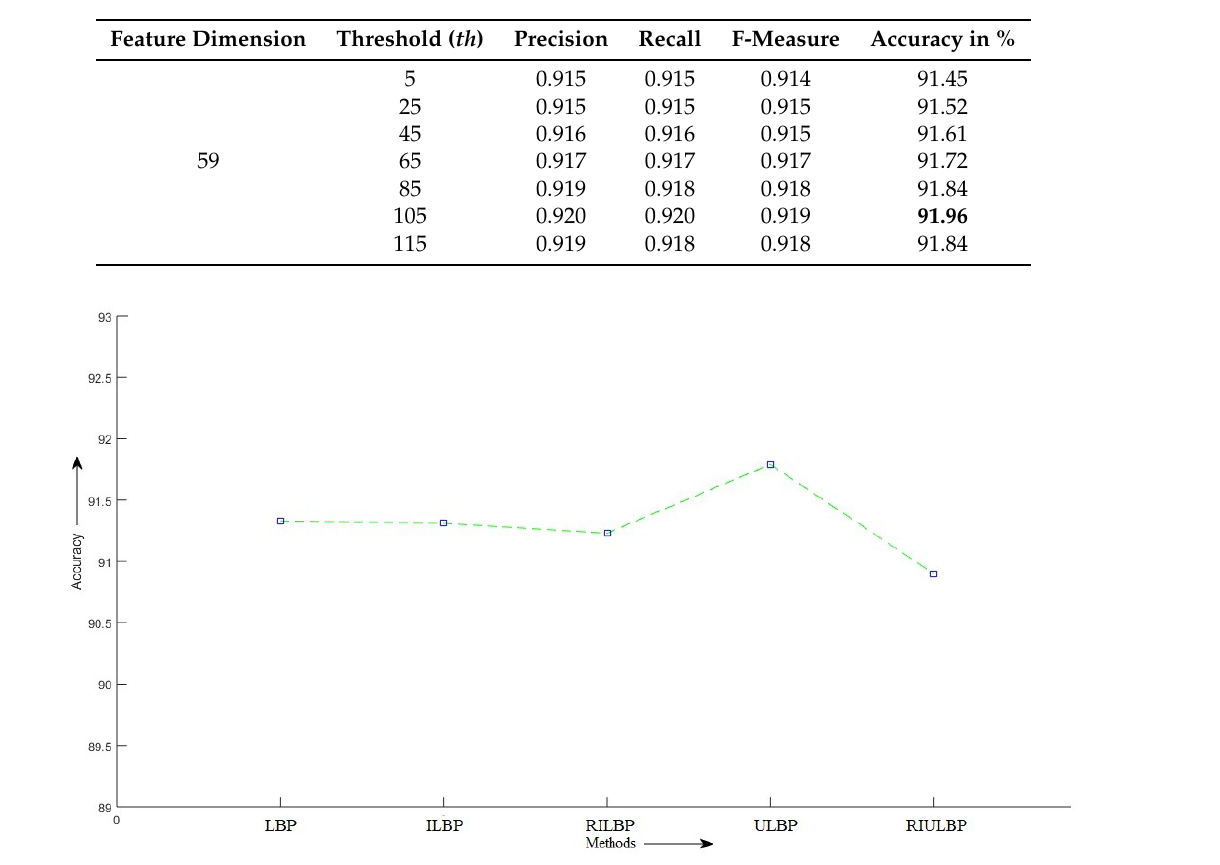
Table 3. Classification results using various thresholds for RULBP. The classification accuracy gradually increases and attains a maximum at a th of 105 units.